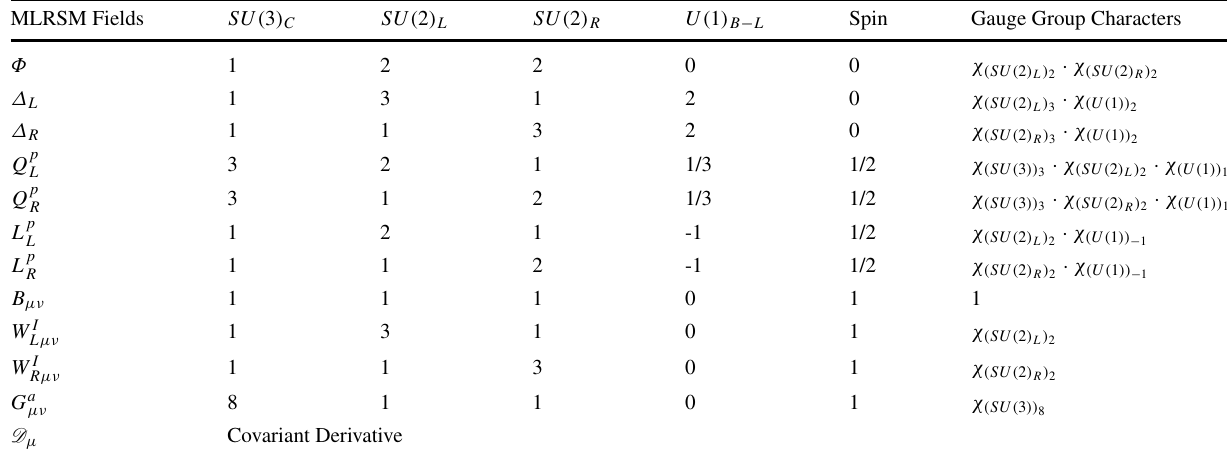
character. Also, I = 1 , 2 , 3 denotes the SU ( 2 ) index, a = 1,2,.....,8 the SU ( 3 ) index and p = 1,…, N f the flavor index. The color and isospin indices have been suppressed. L and R denote whether the fields trans- form non-trivially under SU ( 2 ) L or SU ( 2 )